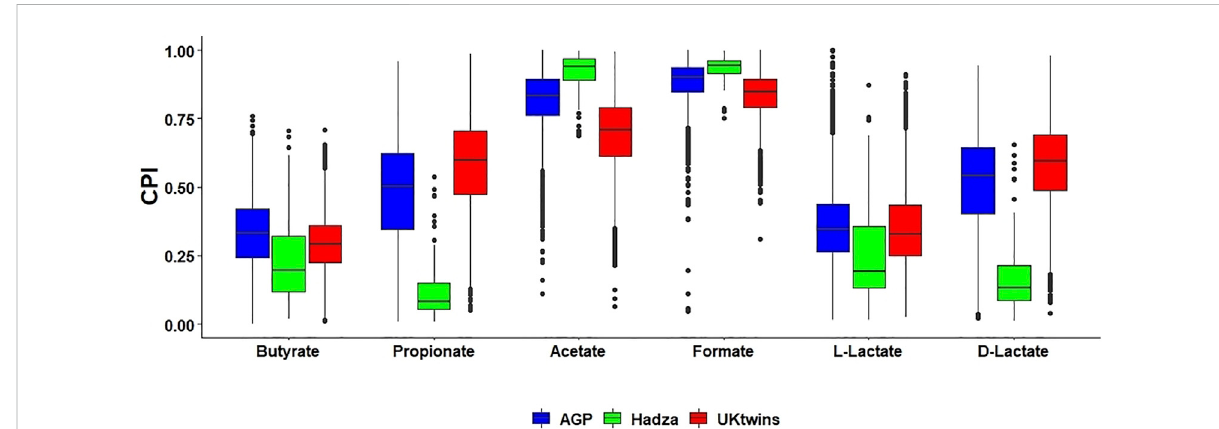
FIGURE 2 Distribution of Community Phenotype Indices (CPI) for SCFAs and lactate in HGM 16S samples from AGP, UKT and Hadza datasets. Box plots with the median values show distribution of CPI values calculated for each 16S sample. Each CPI value corresponds to the relative abundance of bacterial 16S reads possessing predicted metabolic capability to produce a